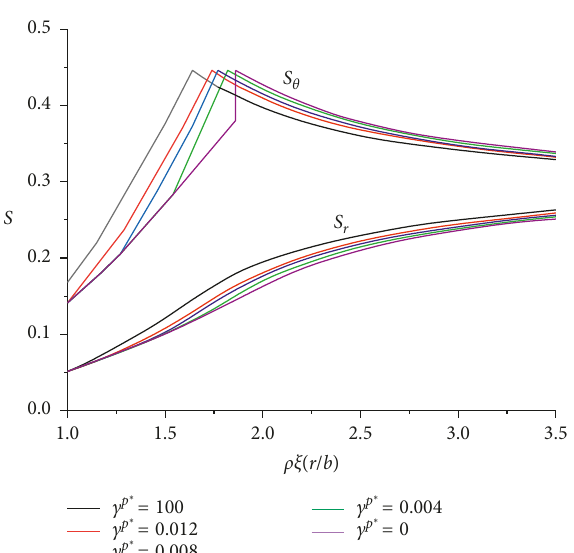
Figure 12: Variation of the dimensionless radial and circumfer- ential stresses with the change of c p